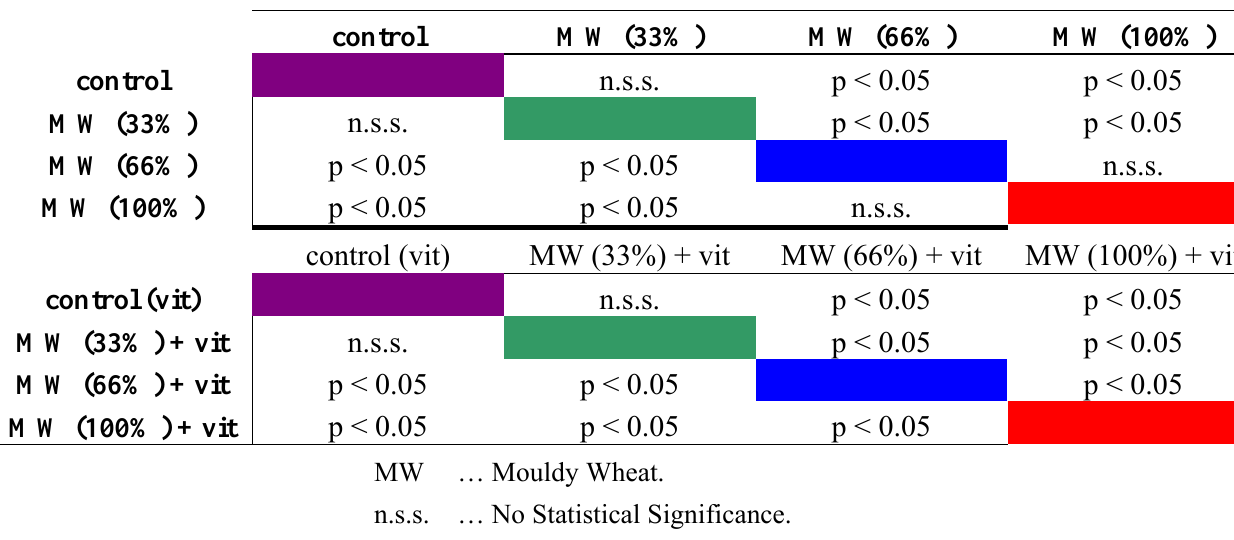
Table 3. Statistical treatment of metallothionein content by using one way ANOVA, Scheffeho test. Differences with p < 0.05 were considered significant, N.S.S. means any statistical